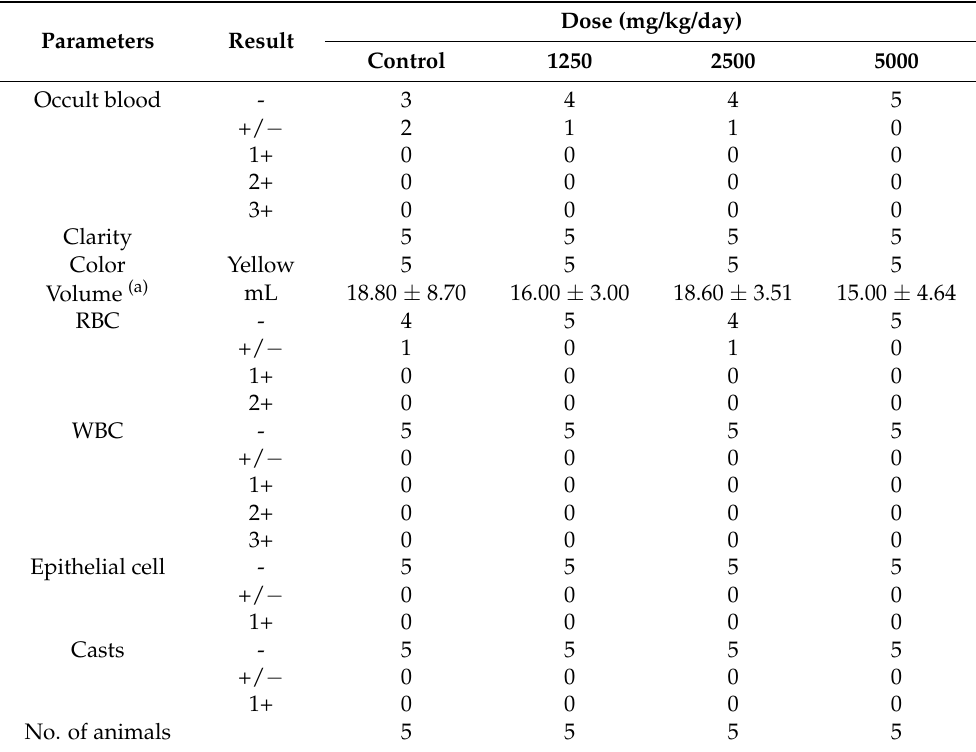
Table 5. Cont. Parameters